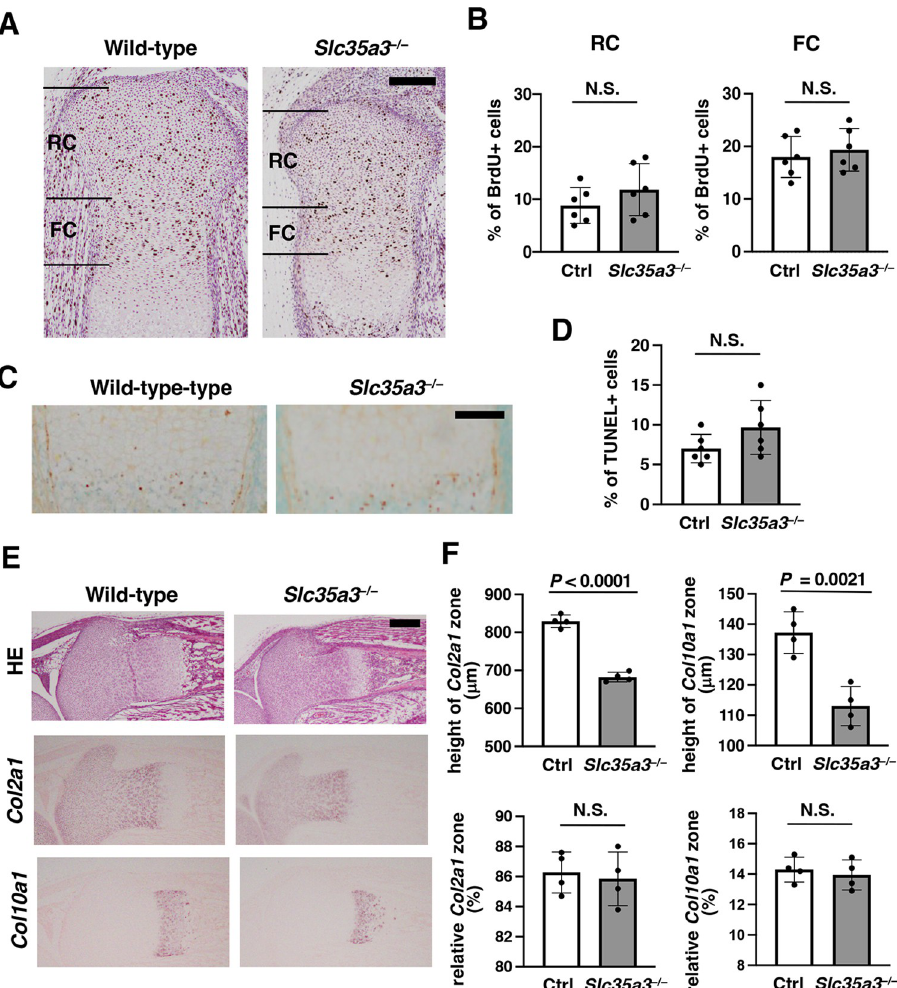
Fig 5. Proliferation, apoptosis, and differentiation are not affected in Slc35a3 −/− chondrocytes. (A) BrdU staining of the tibia sections from the BrdU-treated embryos at E18.5. RC, round chondrocyte zone; FC, flat chondrocyte zone. ( B ) Frequency of BrdU-positive cells in the RC and FC zones. (C) TUNEL staining of the hypertrophic chondrocyte zone in the tibia sections at E18.5. (D) Frequency of TUNEL-positive cells in the hypertrophic chondrocyte zone. (E) HE staining and in situ hybridization (ISH) images, produced using Col2a1 and Col10a1 probes of the tibia sections at E18.5. (F) Heights of Col2a1 - and Col10a1 -expressing zones (upper graphs), and the relative heights of Col2a1 - and Col10a1 -expressing zones normalized by the total heights of the growth plate (lower graphs) in the ISH images. Data are shown as the means ± standard deviation; n = 6 (B, D) and 4 (F). Combined values from three (B, D) and two (F) independent sections were compared. Two separate areas were counted in one section (B, D, F). P values were calculated using Student’s t -test. Ctrl, control (wild-type + Slc35a1 +/− ); N.S., not significant. Scale bars, 200 μ m (A, E) and 100 μ m